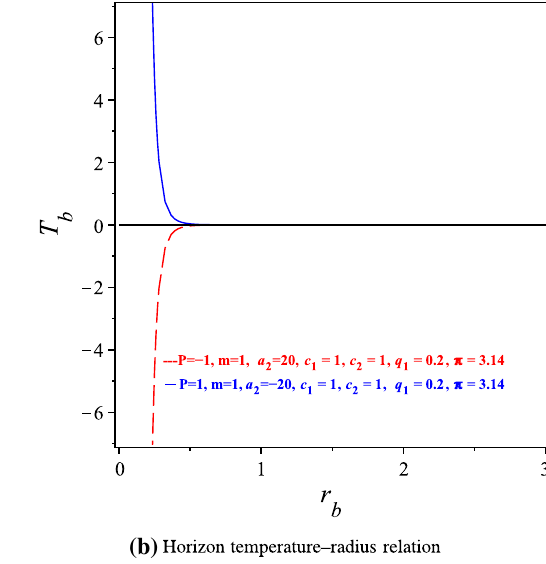
Fig. 2 Schematic plots of the degenerate horizons of solution (33): a The plot of A ( r ) shows the black hole event horizon, r b , and the cos- mological horizon, r c , where m > m min . At m = m min ( r b = r c ), the